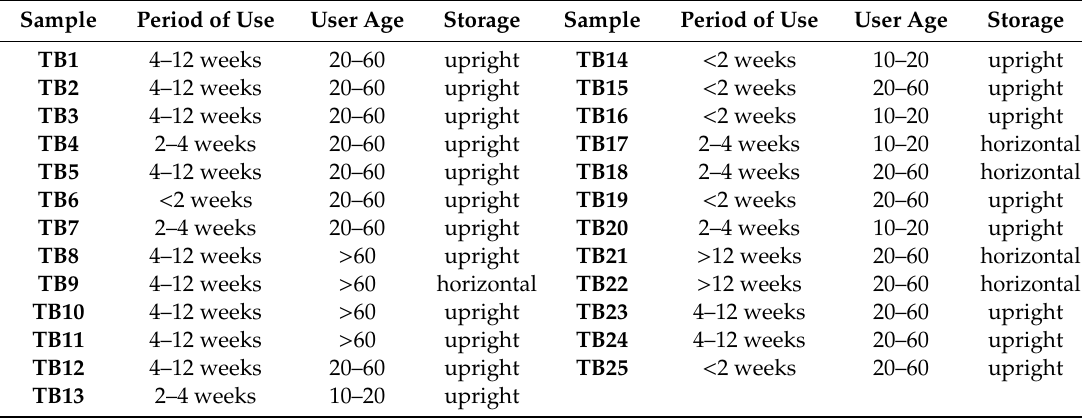
Table 4. Overview of the period of use of toothbrush (TB) samples, the age of the users, and storage conditions from di ff erent households in North Rhine-Westphalia (Germany).